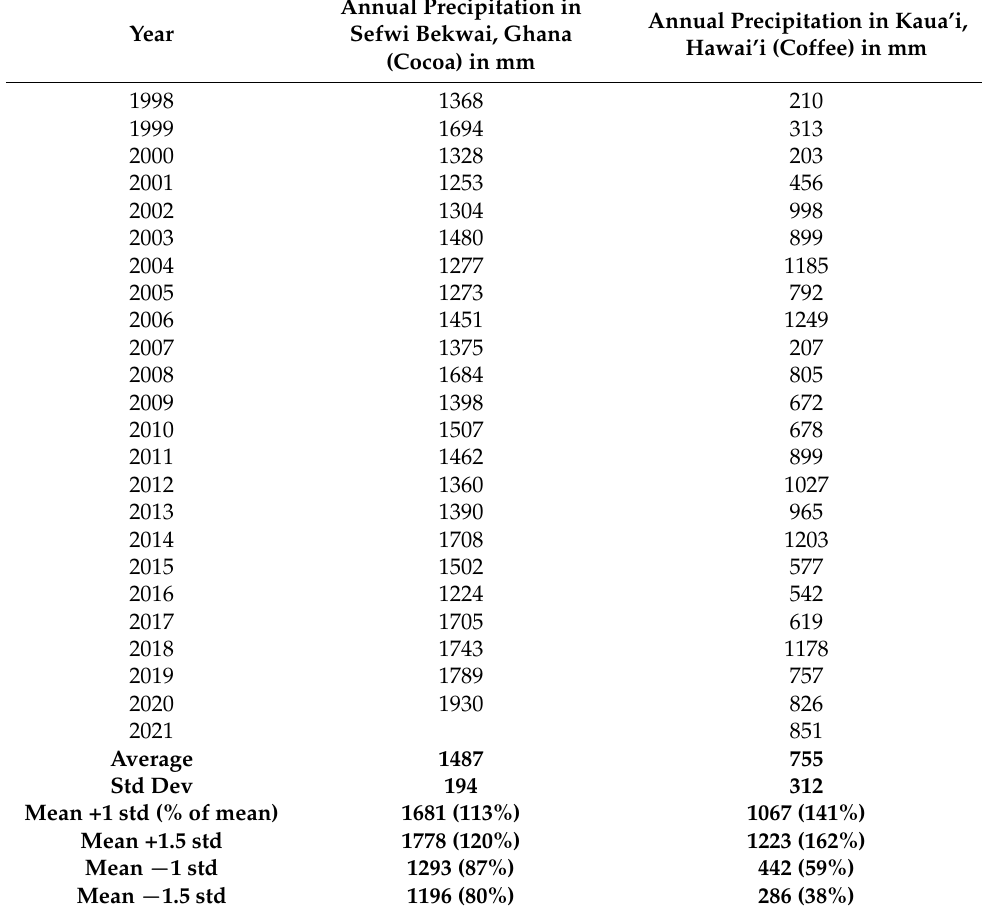
Table 6. Analysis of the annual rainfall data for twenty-four years at the two